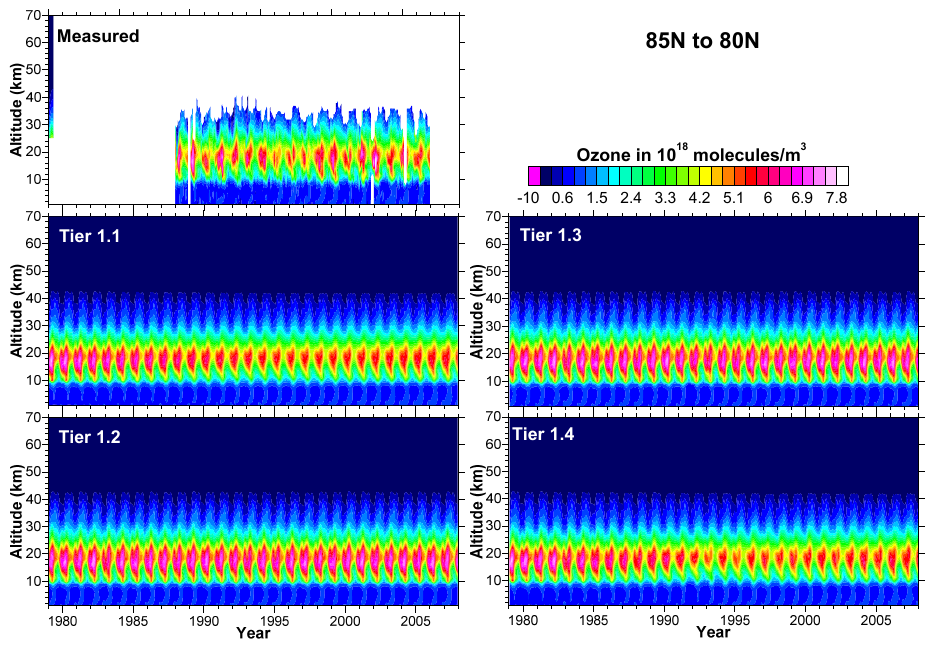
Figure 6. The Tier 0 ozone number densities between 80 ◦ N and 85 ◦ N (upper left panel marked “Measured” to denote that these are the original monthly means), together with the Tier 1.1, 1.2, 1.3 and 1.4 time series.